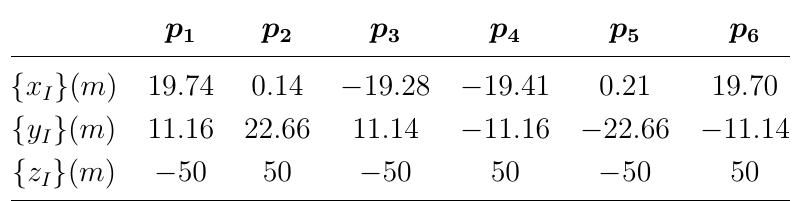
Table 4. Optimal sensor positions for σ = 0 . 05 rad , η = 0 . 1 and γ = 1